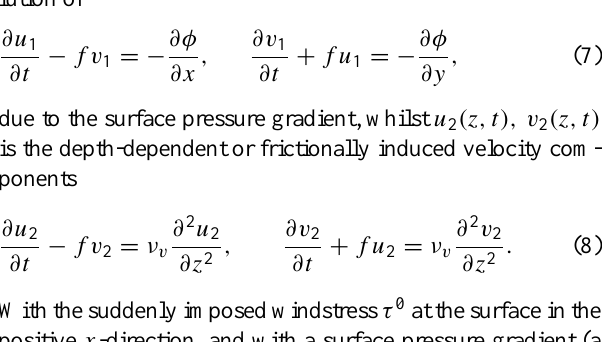
have been discussed by Krauss (1979) and Csanady